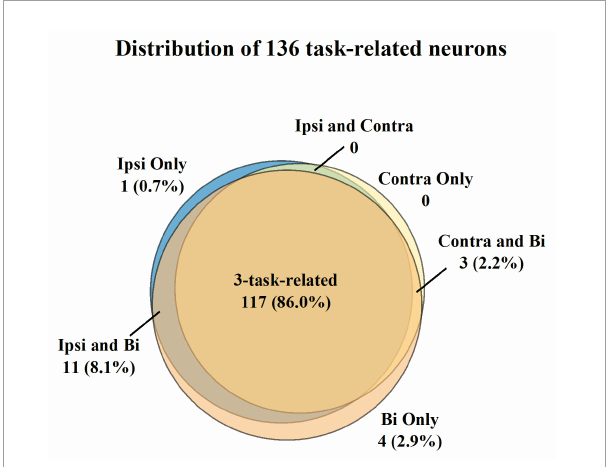
FIGURE2 Classification of the 136 neurons with the mean firing rate > 1 Hz across three tasks. A neuron was judged to be task-related to a specific movement if its modulation ratio was higher than one during this specific movement. Most neurons (86.0%) were considered 3-task-related. Further analysis was compiled from the neural activity of 3-task-related